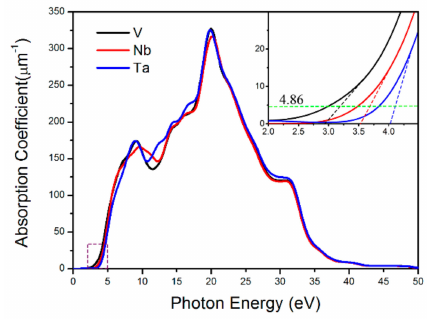
Figure 4. The absorption spectra of BaMO(IO 3 ) 5